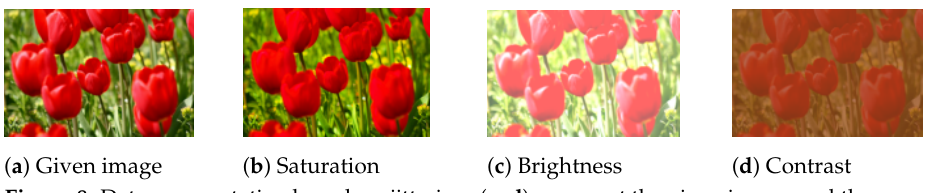
Figure 8. Data augmentation by colour jittering. ( a – d ) represent the given image, and the augmented images by manipulating the colour saturation, brightness and contrast,